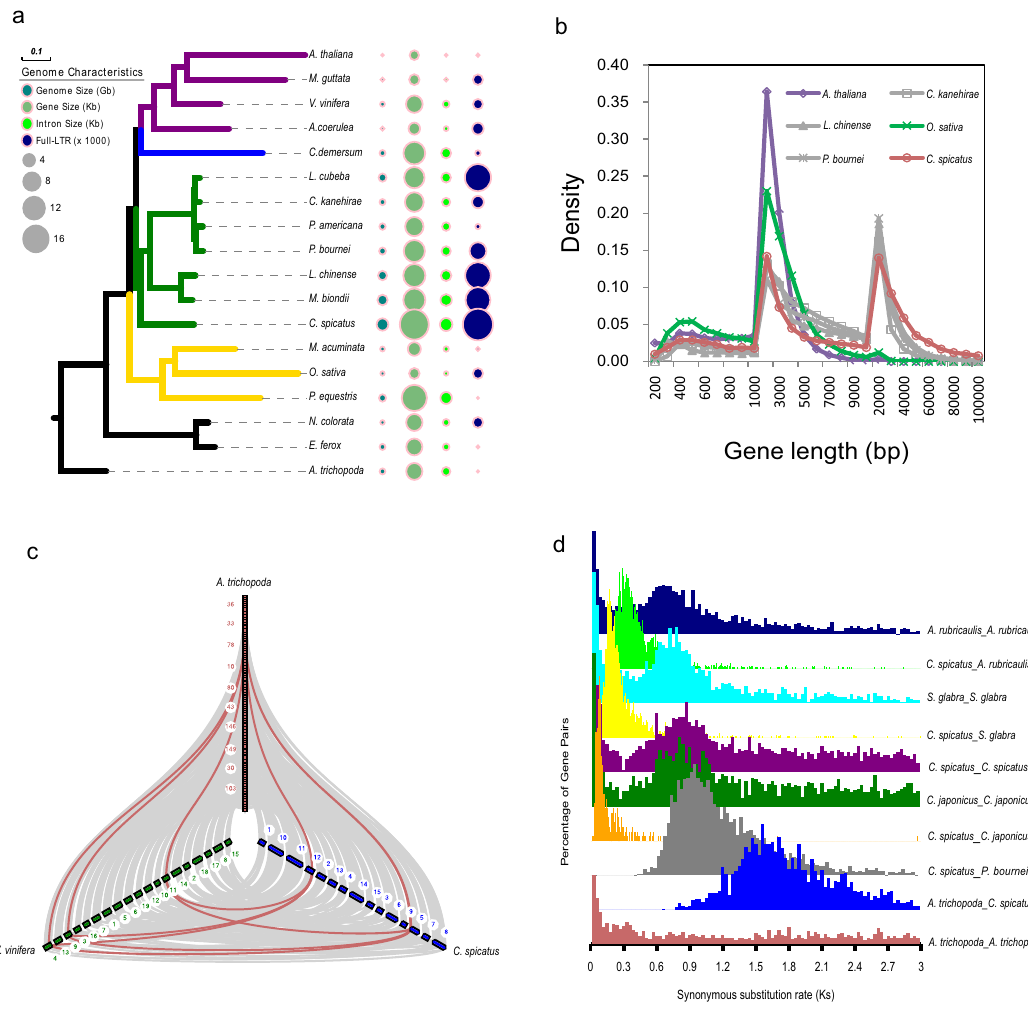
Fig. 2 The prevalence of longer genes and introns, and con fi rmation of a whole-genome duplication event in C. spicatus based on genomic collinearity. a Comparison of gene and genome characteristics (i.e., genome size, gene size, exon, and intron sizes) of C. spicatus and 17 other fl owering plants. b Comparison of the lengths of the coding regions among nine representative plant genomes. c Collinearity patterns between genomic regions of Amborella , Vitis , and Chloranthus . The colored (red/grey) wedges highlight the major syntenic blocks shared among these species. d The number of synonymous substitutions per synonymous site ( Ks ) distributions con fi rming the occurrence of a whole-genome duplication (WGD) event in C. spicatus . Source data underlying Fig. 2a are provided as a Source Data fi